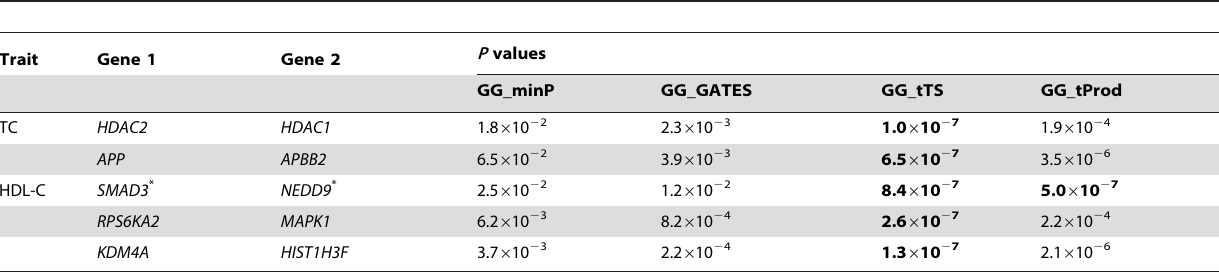
Table 3. Significant ( P , 9.4 6 10 2 7 ; bolded) gene-level interactions affecting total cholesterol (TC) and high-density lipoprotein cholesterol (HDL-C) levels in data from the ARIC